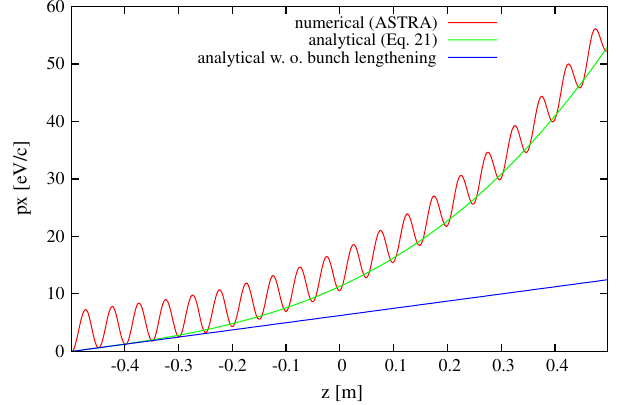
FIG. 2 (color online). Development of the transverse momen- tum in a 1 m long S-band structure (cos φ 0 ¼ 1 ). The particle starts parallel to the cavity axis with 1 mm transverse offset and 1 μ m longitudinal offset relative to the bunch center. The structure is matched to the particle energy of 5 MeV and has an effective voltage of − 0 . 2